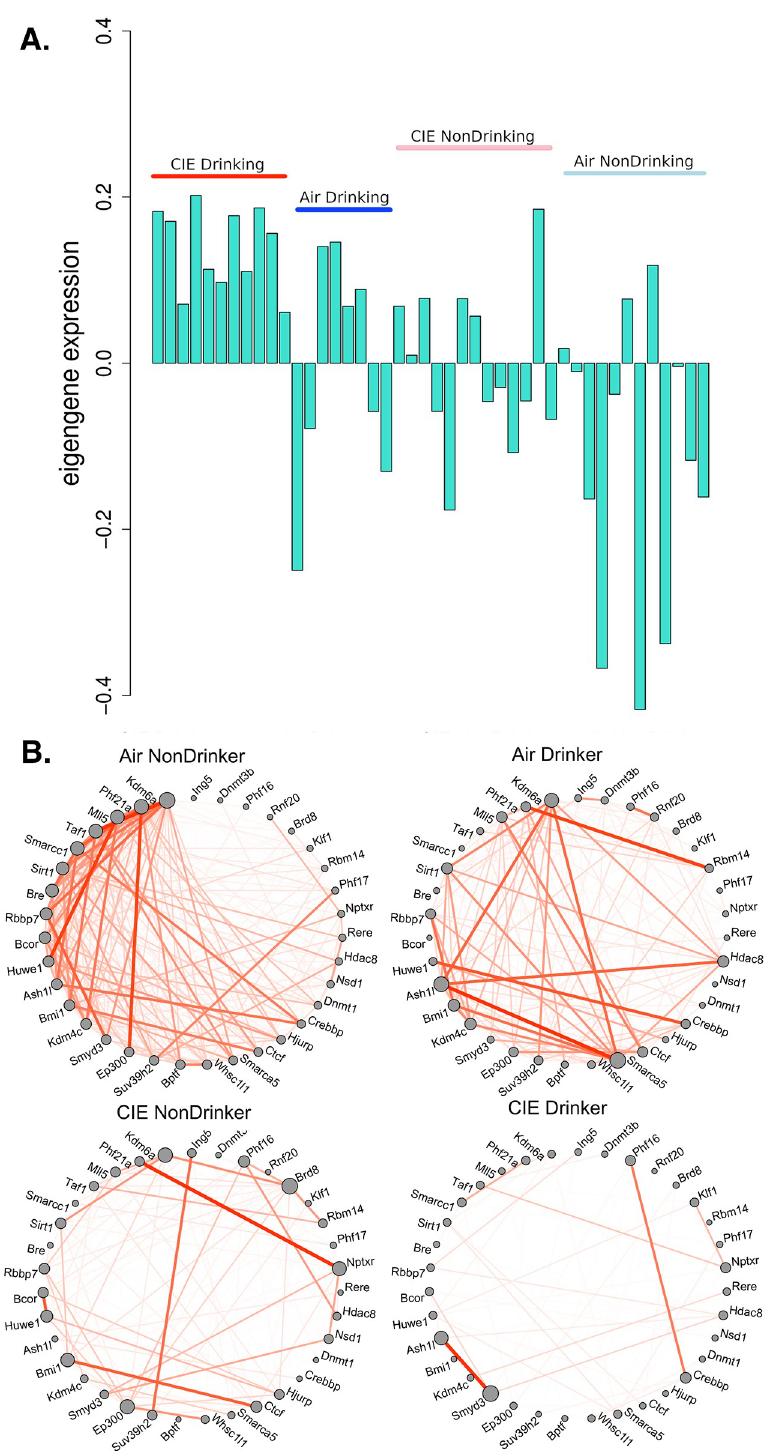
Fig 7. Eigengene expression for each sample in PFC turquoise module and connectivity of chromatin modification genes. A) Eigengene (1 st principal component) value from each PFC sample. Red = CIE Drinking, Blue = Air Drinking, Pink = CIE NonDrinking, Light blue = Air NonDrinking. B) Connectivity, represented by expression correlation, between genes involved in chromatin modification for each group. Line thickness and opacity represent strength of connectivity between